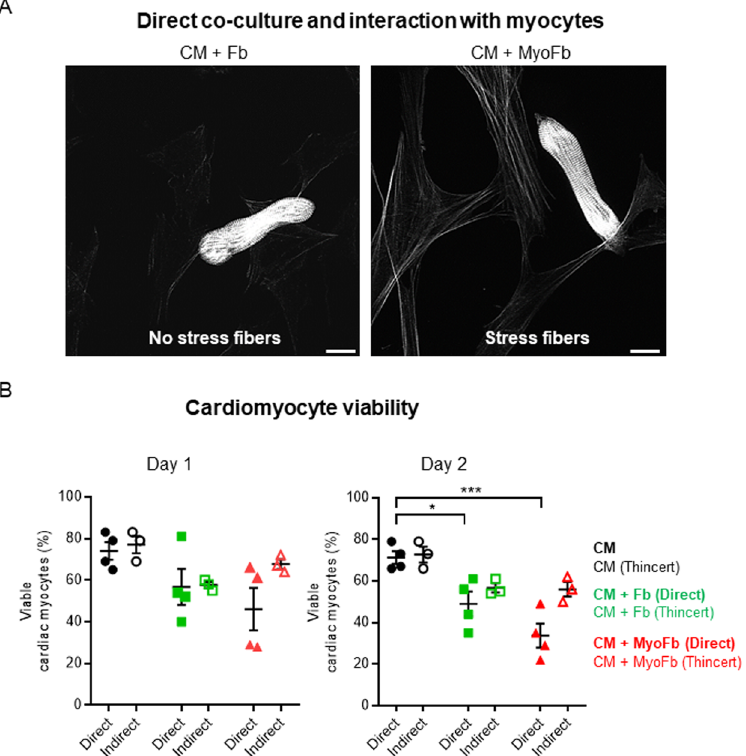
Figure 2. Co-culture of CMs with Fbs and MyoFbs reduces CM viability. ( A ) Example of direct co-cultures of CMs with Fbs (left) and MyoFbs (right) after fixation and staining for F-actin. Stress fibers are visible in the MyoFbs but absent in the Fbs. ( B ) Percentage of live CMs after 24 and 48 hours in direct and indirect (Thincert) co-culture. (N cultures = 4 for direct and 3 for indirect; two-way ANOVA with Bonferroni post hoc test * p = 0.0344, *** p =